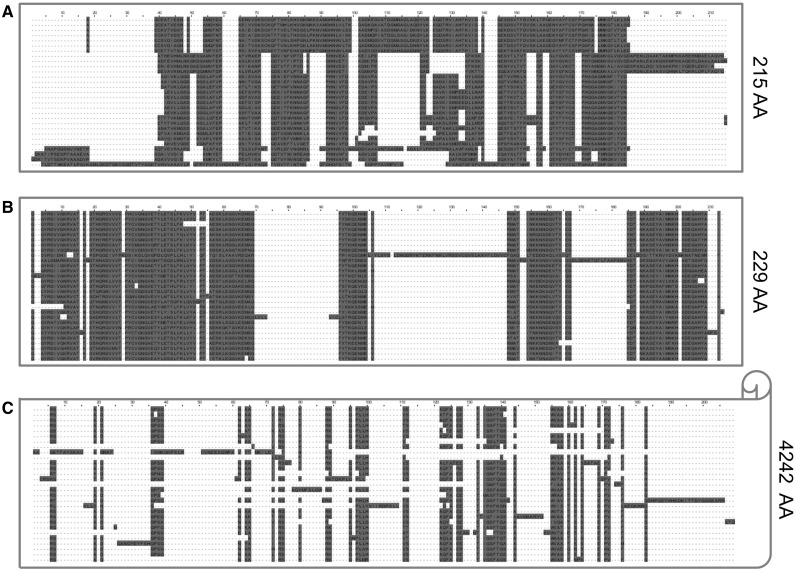
SPARTA can be used to simulate MSAs similar to a target MSA. The plot depicts three MSAs. The real Azurin MSA (panel A), a simulated MSA using the parameters the algorithm inferred for the Azurin MSA (IR = 0.0135, a = 1.325, RL = 119; panel B) and a simulated MSA using INDELible’s default parameters (as described in the Materials and Methods section) (panel C). As the MSA simulated based on the default parameters is 4,242 amino acids long, only the first 200 columns are presented in the plot.